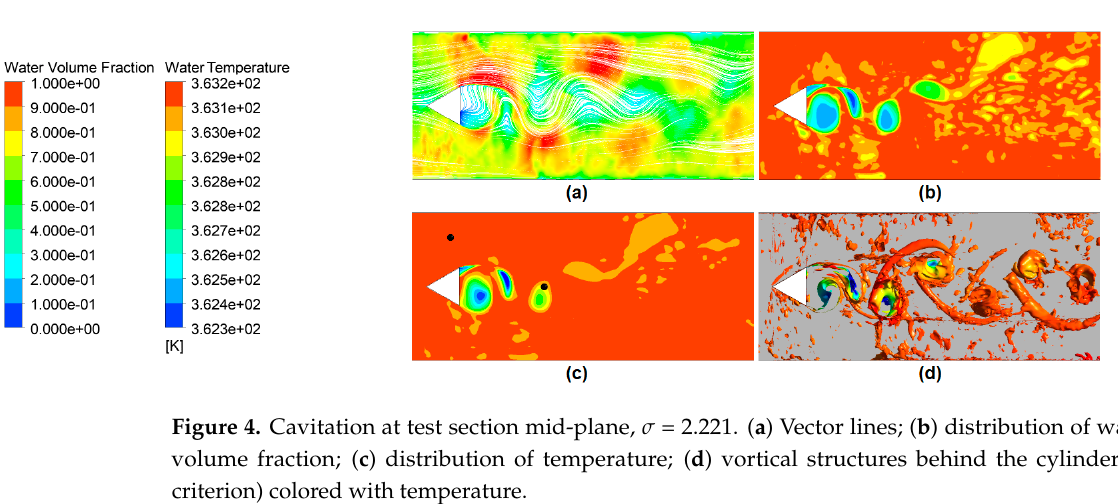
Figure 3. Comparison of CFD results with experimental data by Le and Iga [31].